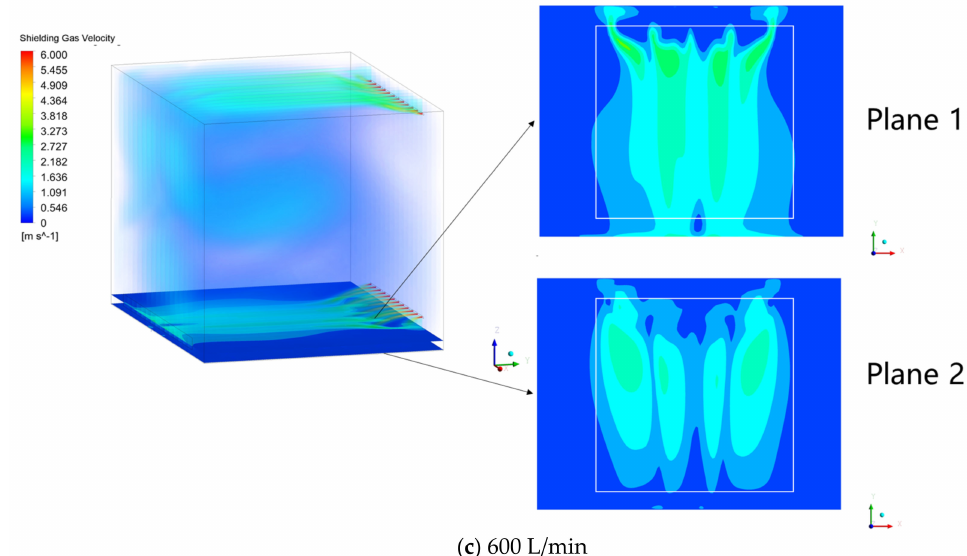
Figure 6. The velocity fields in the working chamber with different shielding gas volume flows.